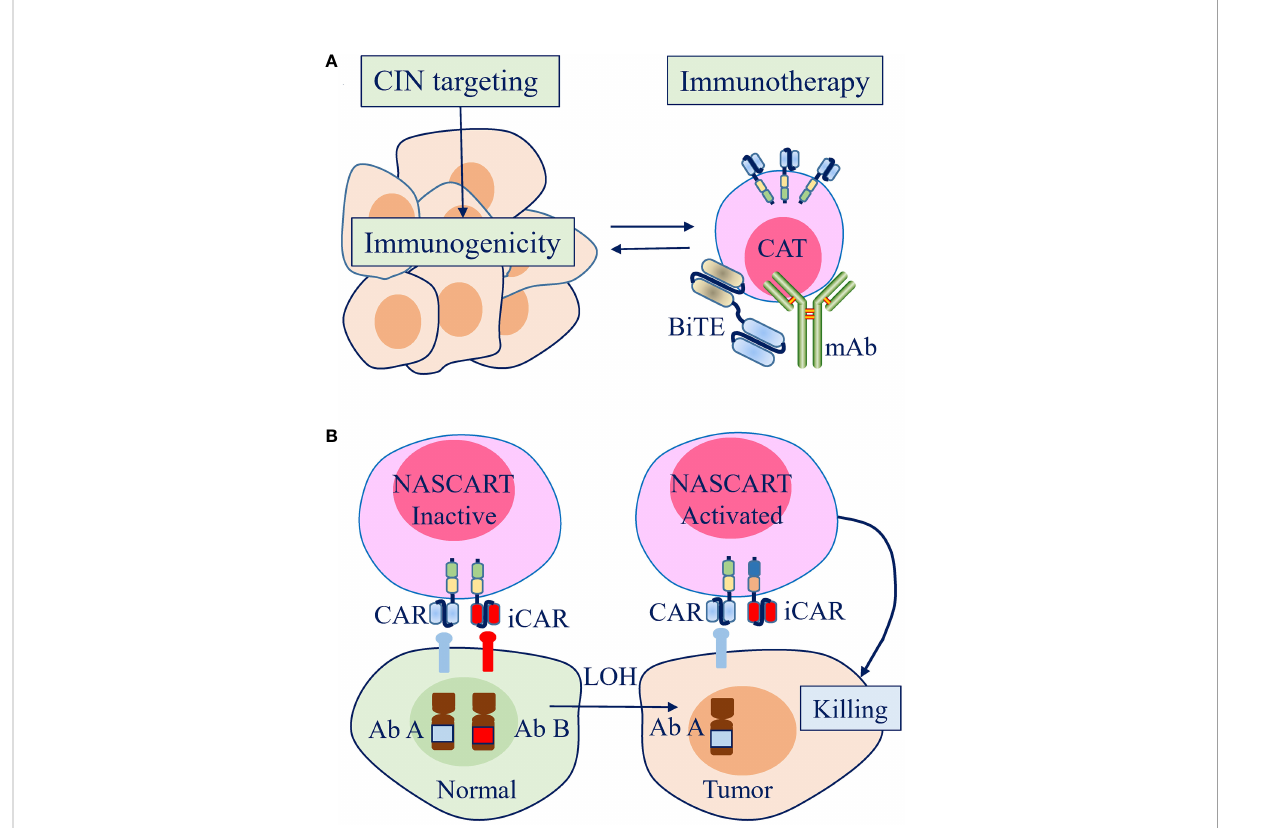
FIGURE 4 Therapeutic strategies to leverage chromosome instability (CIN) and aneuploidy to enhance the ef fi cacy of antitumor immunotherapy in the clinic. (A) Strategies promoting CIN can increase the immunogenicity of tumor cells, which can be combined to enhance the ef fi cacy of antitumor immunotherapy. (B) A pairwise chimeric antigen receptor (CAR) platform, Neoplasm-targeting Allele-Sensing CAR (NASCAR), has the potential to target loss of heterozygosity (LOH), which is mostly contributed by CIN/aneuploidy. The activating and inhibitory CARs were designed to target polymorphic forms of the same molecule or to target different molecules, but both with the inhibitory molecules were lost by LOH in tumor